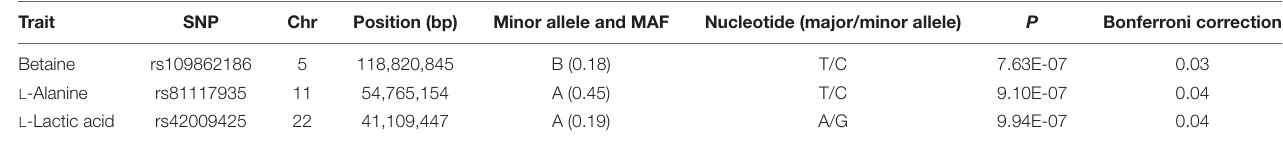
TABLE 3 | SNPs significantly associated with metabolites: chromosome (Chr), position of SNP on chromosome (bp), minor allele and minor allele frequency (MAF), nucleotide of SNP, P values of significant test and Bonferroni correction of P